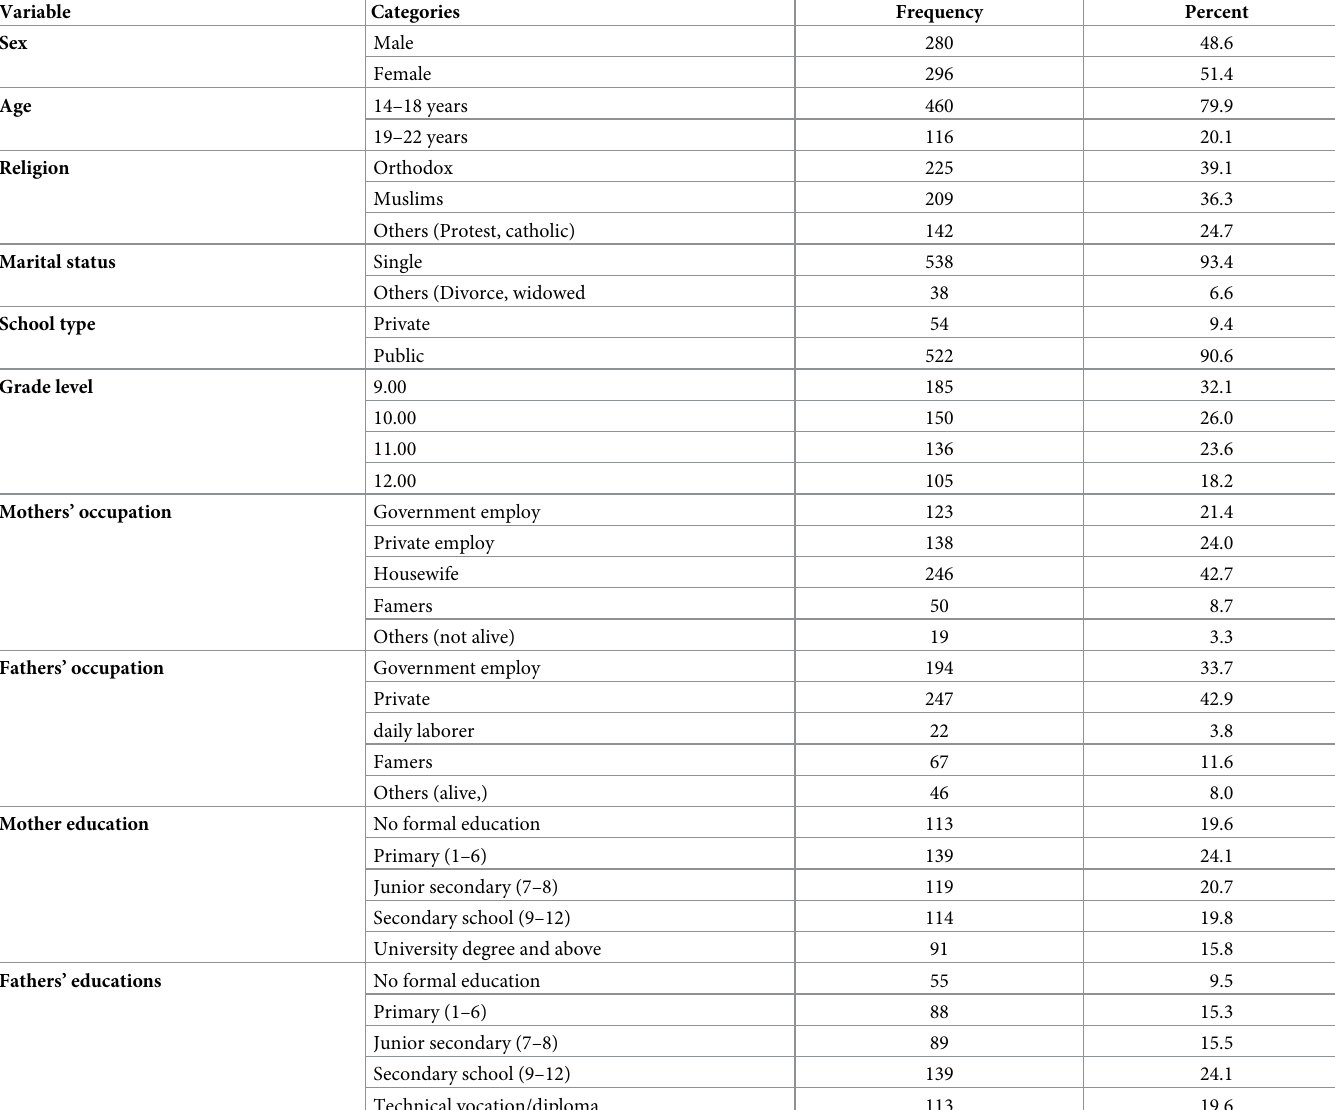
Table 1. Socio-demographic characteristics of the study participants, Jimma town, Oromia, Ethiopia,